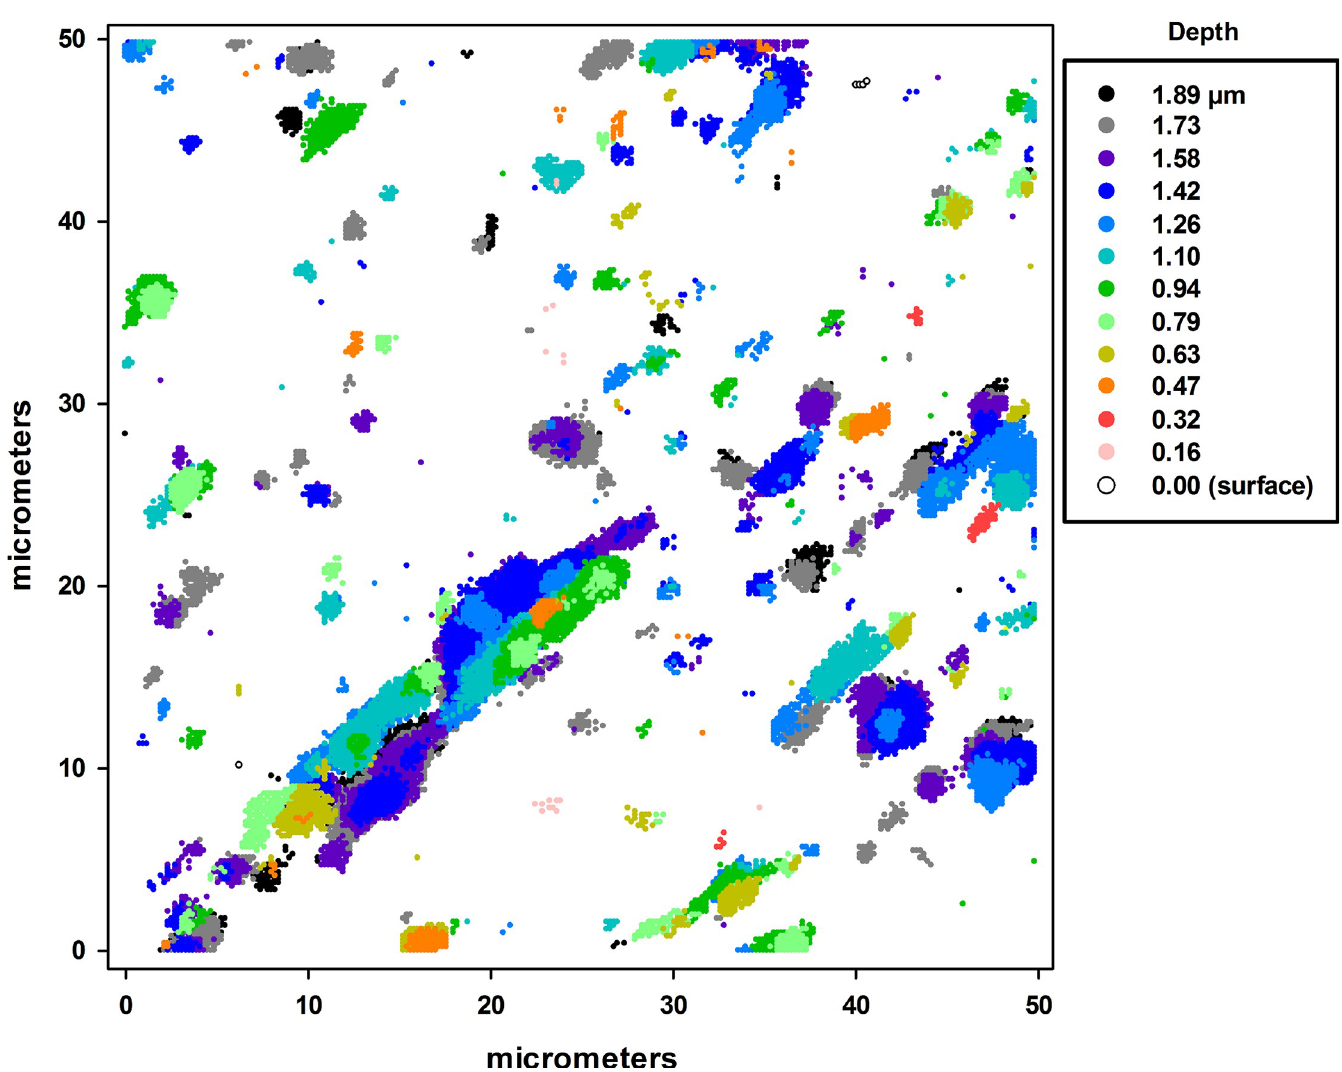
Fig 10. Three-dimensional stacked scatterplot of the points with high 35 Cl - secondary ion emissions (I x � 50) in a 50 μ m x 50 μ m area of an acetone-washed fiber with the depth of each data point indicated by its darkness. Data is plotted to simulate the view from the fiber surface into the direction of the core. Data points lying closest to the surface (depth < 0.5 μ m) are circled for